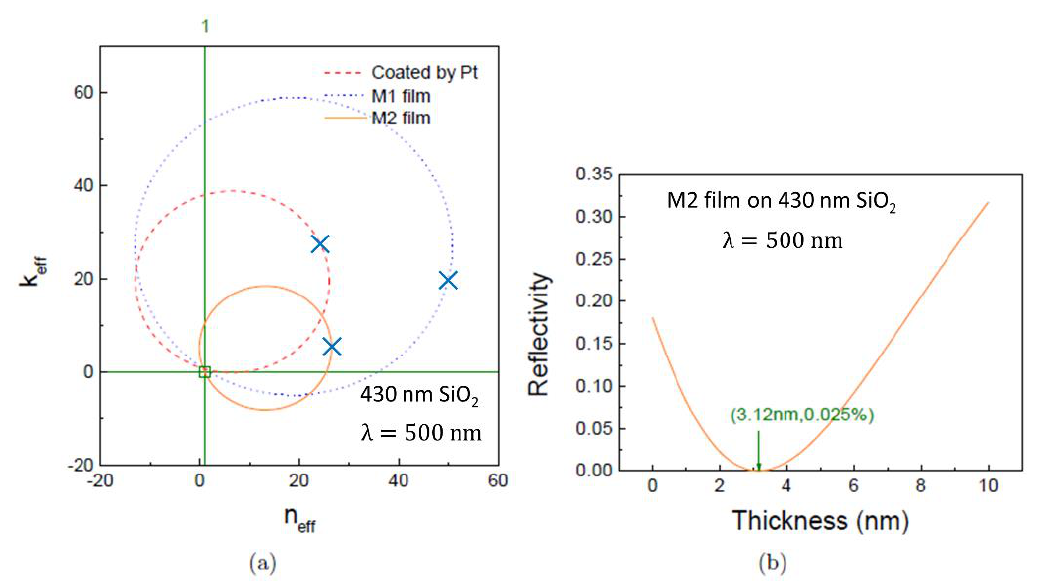
Figure 4. ( a ) The examples of theoretical modelling where the e ff ective optical constant, N e ff , can achieve the value 1 + 0 i , i.e., 100% anti-reflection. They are obtained for a triple layer structure, consisting of a thin metal nano-film, an insulating oxide layer such as SiO 2 and a substrate such as n-doped Si. The circles are the 2D projections of the d 1 trajectories onto the ( n e ff , k e ff ) plane as explained in Figure 3. Di ff erent circles of N e ff correspond to di ff erent values of the optical constants, N 1 . The red (dashed) projection is obtained for a Pt film with N 1 = 3.20 − 4.3 i . The blue (dashed) and orange (solid) projections represent artificial metals M1 and M2 with N 1 = 3.2 − 6 i and N 1 = 0.86 − 4.3 i , respectively. All N 1 values are taken from Table 1. For example, the orange circle associated with the film M2 crosses the horizontal axis at position (1,0), N e ff = 1 + 0 i , which implies 100% anti-reflection or zero reflection. The ( n e ff , k e ff ) values corresponding to the absence of the metallic film ( d 1 = 0 nm) are marked as blue crosses for Pt, M1 and M2 films. ( b ) The dependence of the reflectivity on the M2 film thickness d 1 is shown. The reflectivity reaches a minimum at a critical thickness value d 1 = 3.12 nm. At this point the minimal reflectivity is equal to 2.5 10 − 4 or 0.025%. Conversely, the transmission at the minimum is